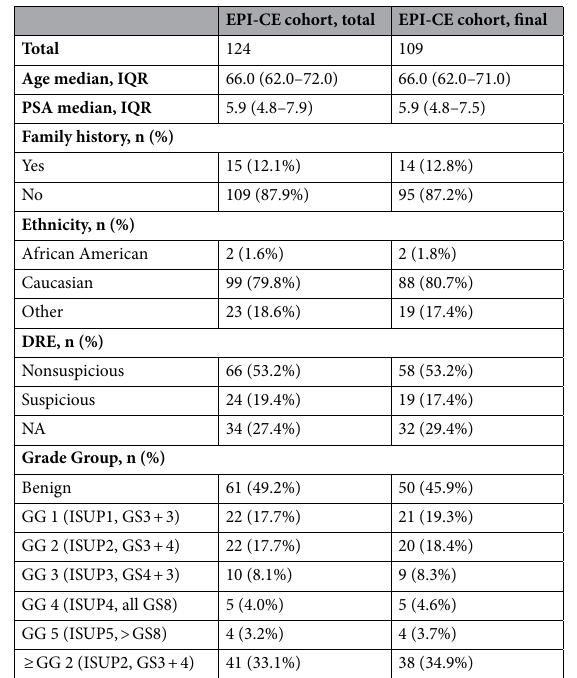
Table 1. Demographic/clinical characteristics for the total 124 and the final 109 cases in the EPI-CE cohort. DRE digital rectal exam, GG Grade Group, GS Gleason score, IQR interquartile range, ISUP International Society of Urological Pathology, PSA prostate-specific